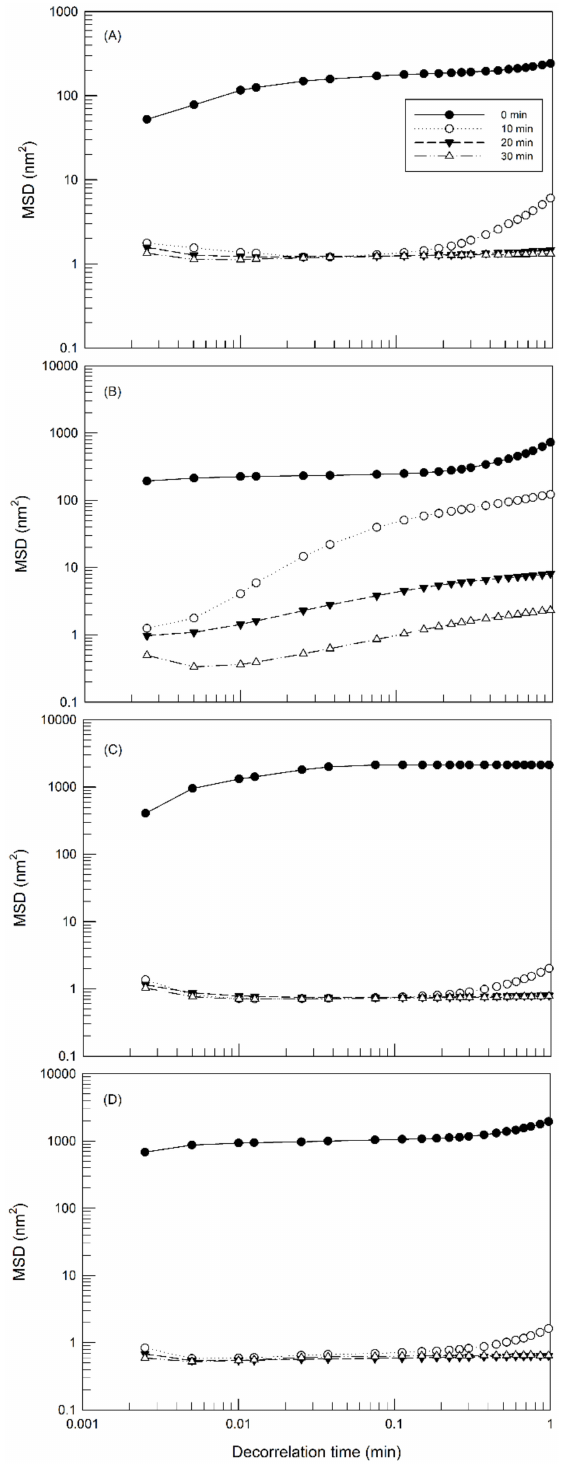
Figure 5. Mean square displacement of hydrogels made up of poloxamer 407 at 20% ( w / w ) alone ( A ) or in the presence of ethosomes ( B ), transfersomes ( C ) and niosomes ( D ) as a function of decorrelation time. The illustrated results were representative of three independent